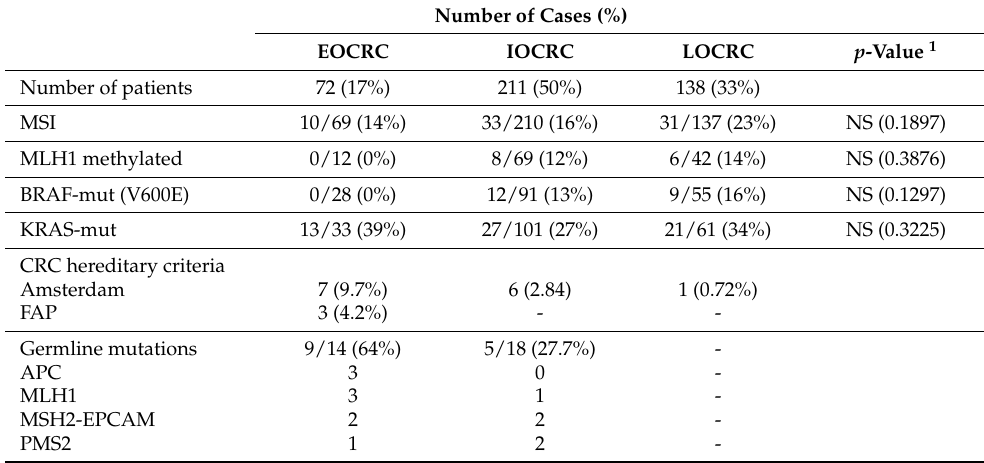
Table 3. Molecular features of tumors and germline genetic analysis of patients according to the age of